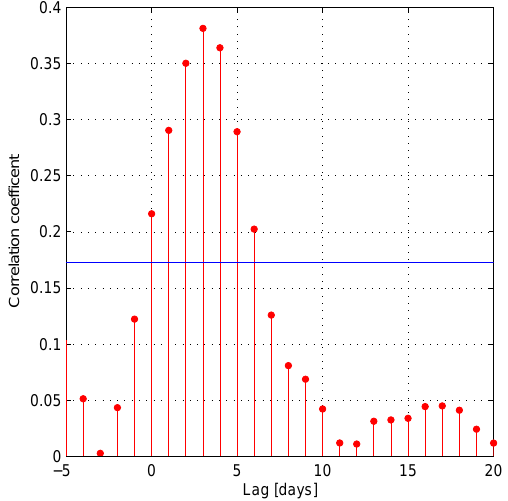
Figure 6. Correlation between westward polar cap stratospheric winds ( ∼ 50km) from MERRA and PW amplitudes ( S 1 + S 2 ) from MLT meridional SuperDARN winds ( ∼ 95km). The stratospheric westward wind leads the PW enhancements in the MLT by approx- imately 3 days with a moderate correlation coefficient of 0.4. The horizontal blue line represents the 99% confidence